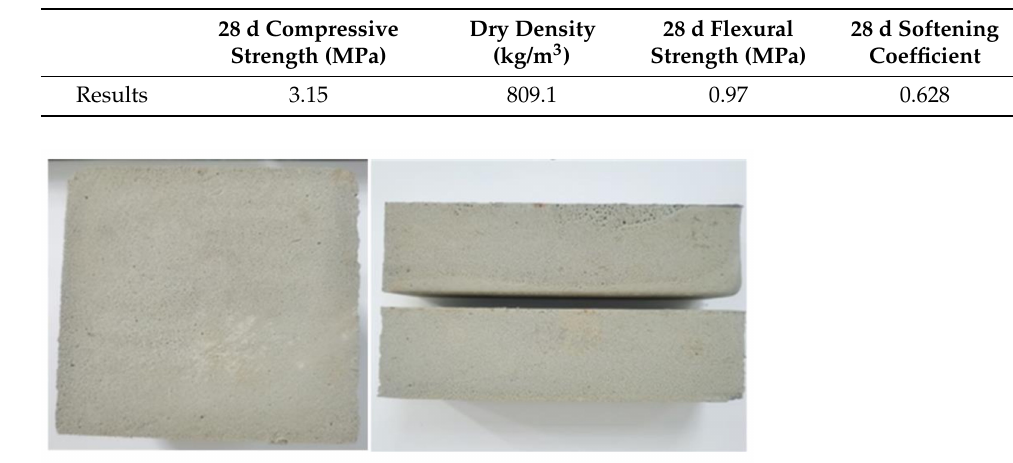
Table 7. Verification experiment results of the optimal mix ratio.